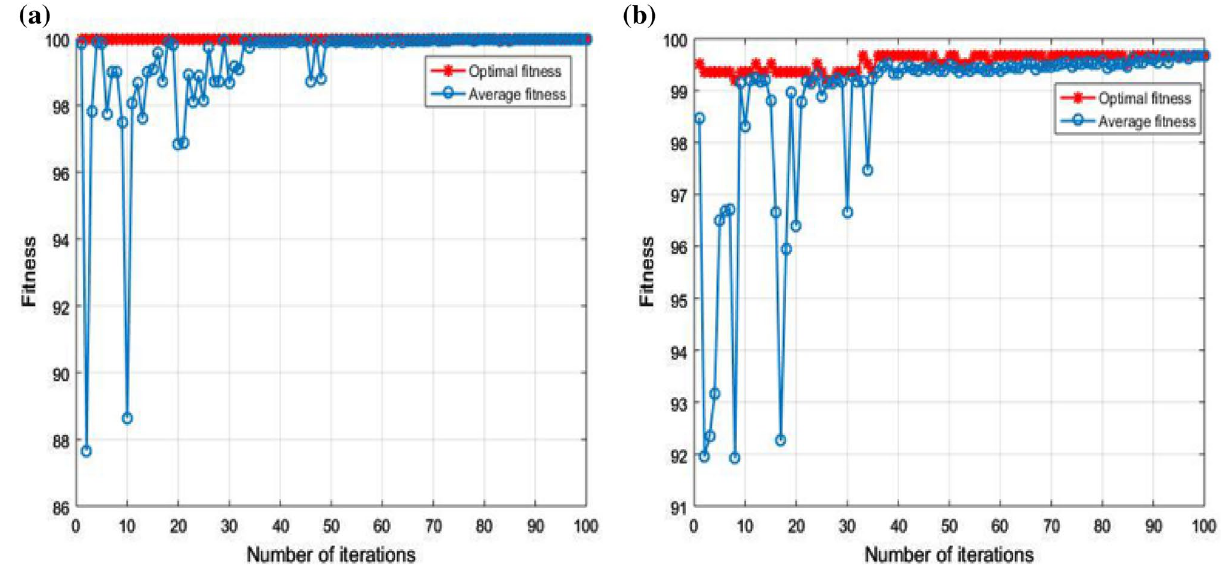
Figure 14. GWO-SVM fitness curve: ( a ) fitness curve for Case 1; ( b ) fitness curve for Case 2.